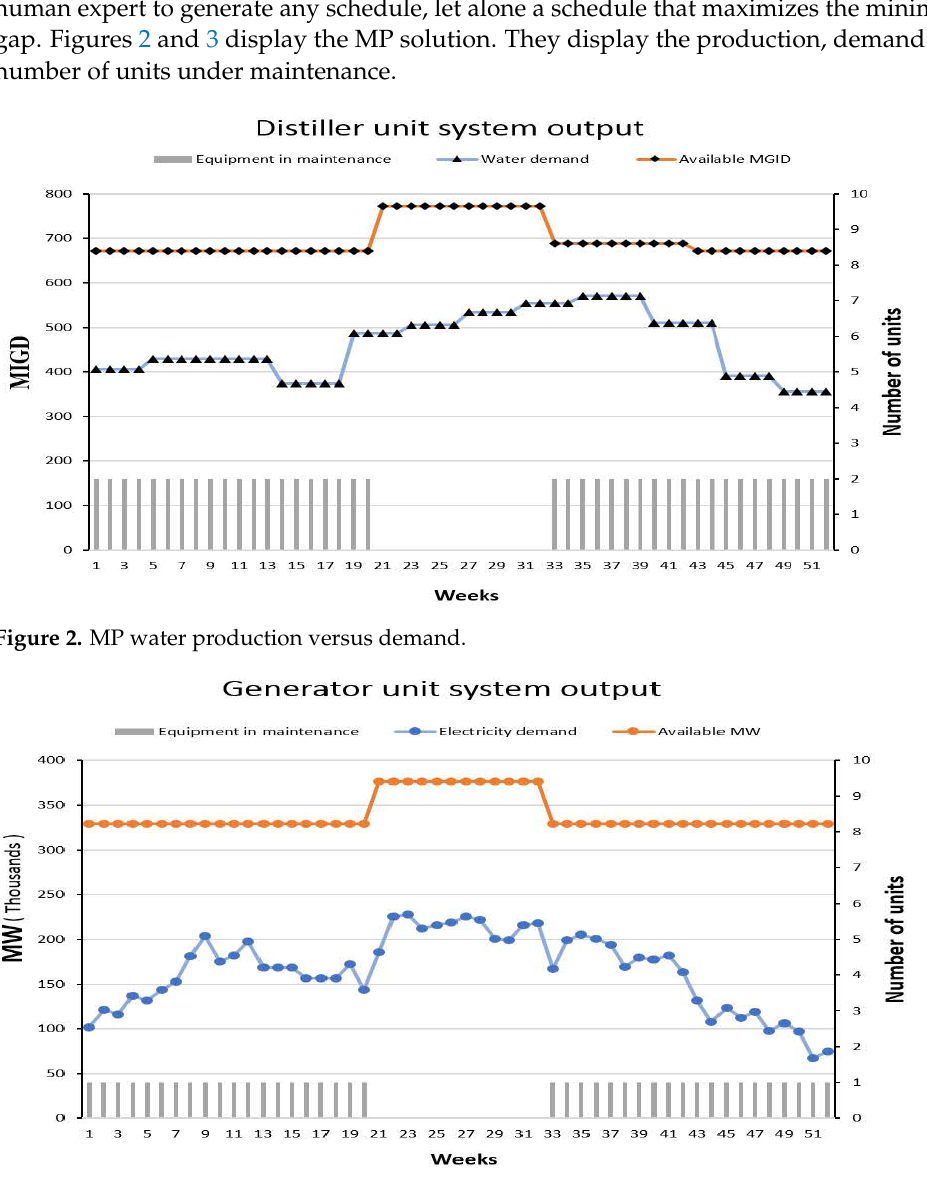
Figure 3. MP electricity production versus